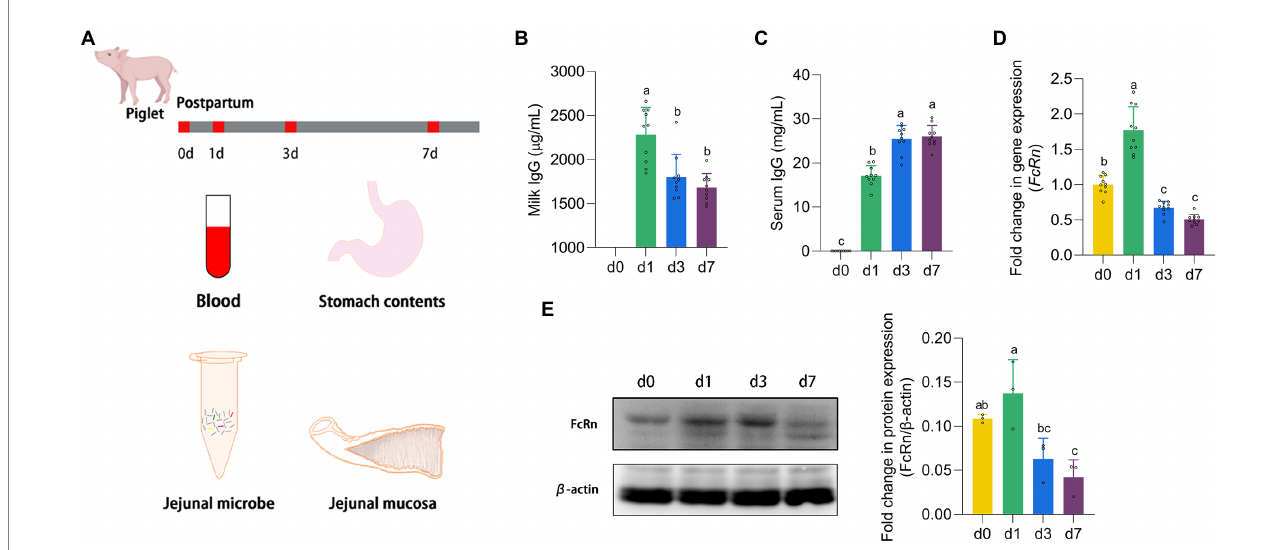
FIGURE 1 The expression of FcRn promoted the absorption of IgG. (A) Animal experiment design. (B,C) The IgG content in stomach milk and serum of piglets at four time points (d 0, 1, 3, and 7). (D,E) The mRNA and protein expression of FcRn in jejunal mucosa of piglets at four time points (d 0, 1, 3, and 7). Data were shown as means ± standard deviations. Mean value without the common letter on data bar in each figure indicated that the difference was significant ( p < 0.05).